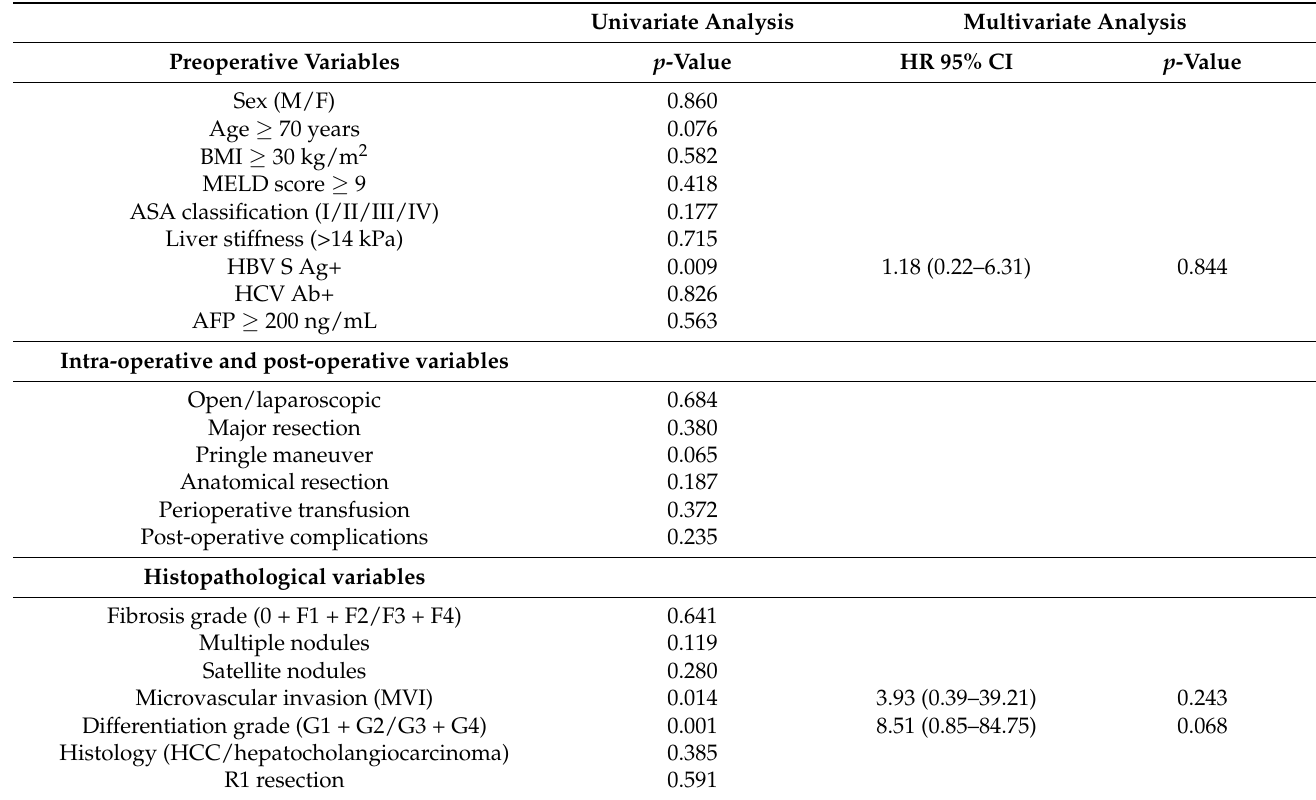
Table 2. Analysis of prognostic factors for tumor recurrence after a liver resection. Univariate Analysis Multivariate